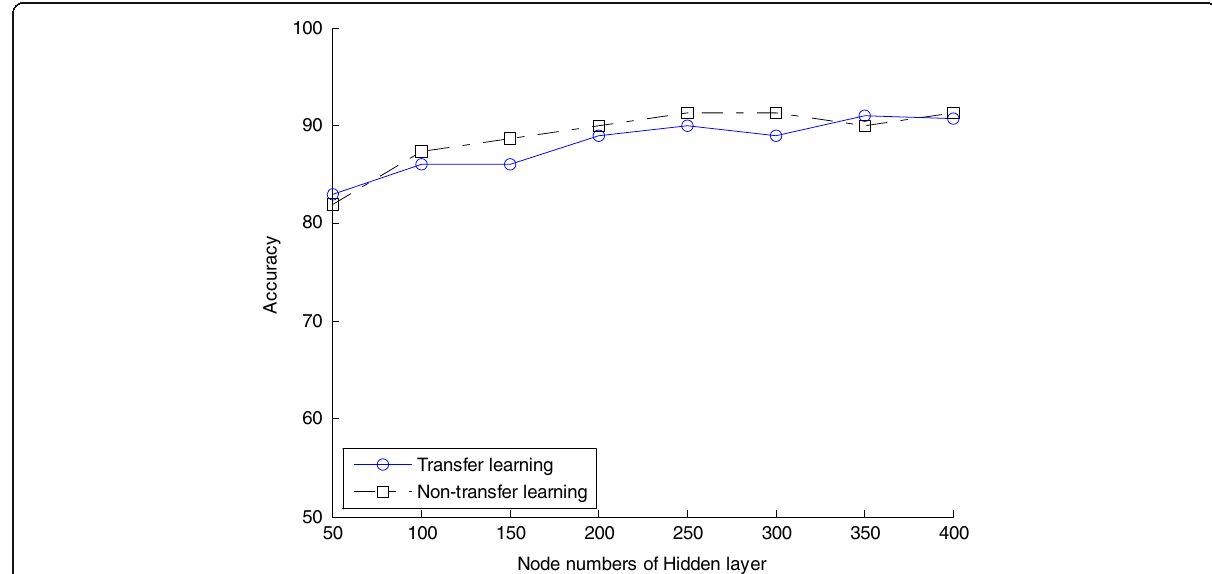
Fig. 7 Classification performance results under the different node numbers of hidden layer